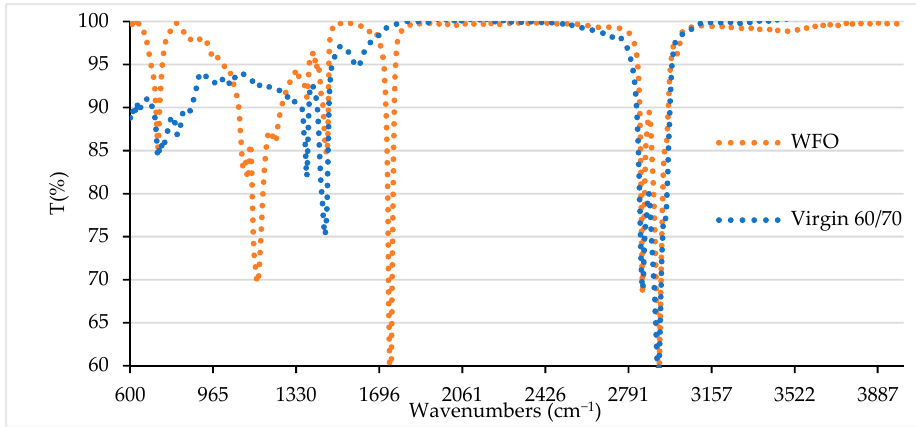
Figure 1. Chemical group absorption peaks in the WFO and bitumen.